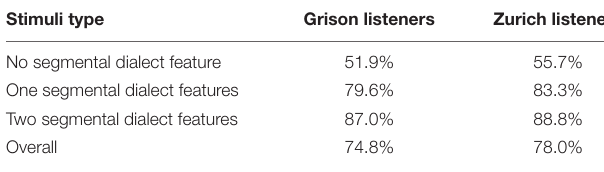
TABLE 3 | Percentage of correct answers per listener group and